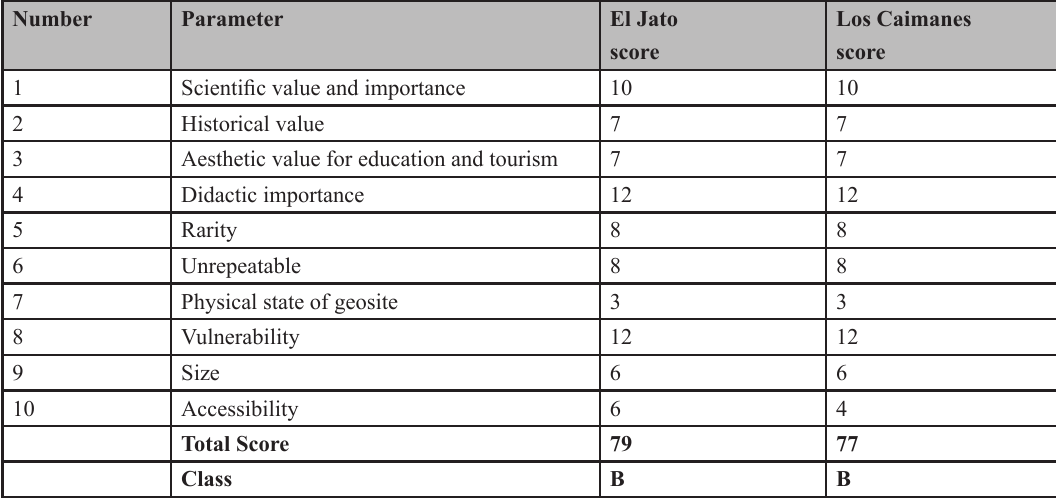
Table 2. Score of both sites for each parameter, total score and class type taken from the methodology proposed by Gutiérrez Domech et al .